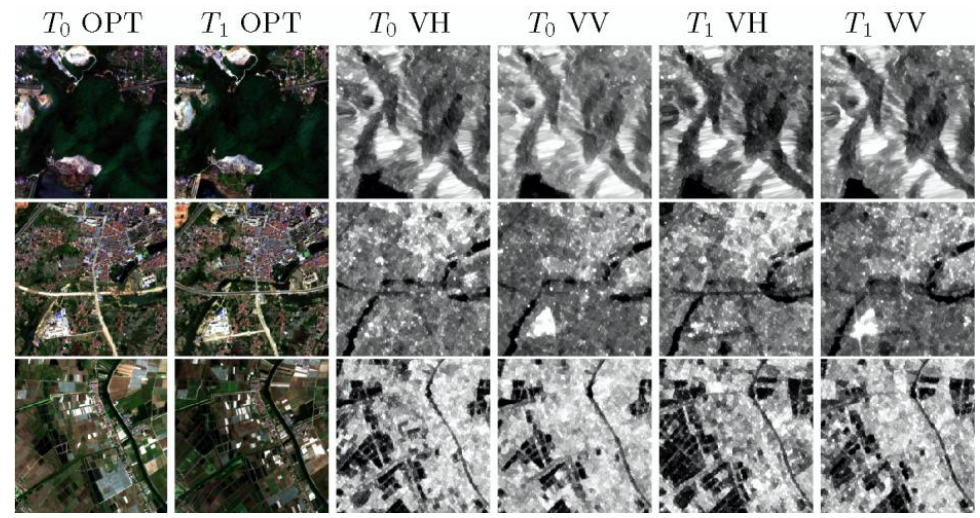
Figure 3. Complicated scenario training sample example.